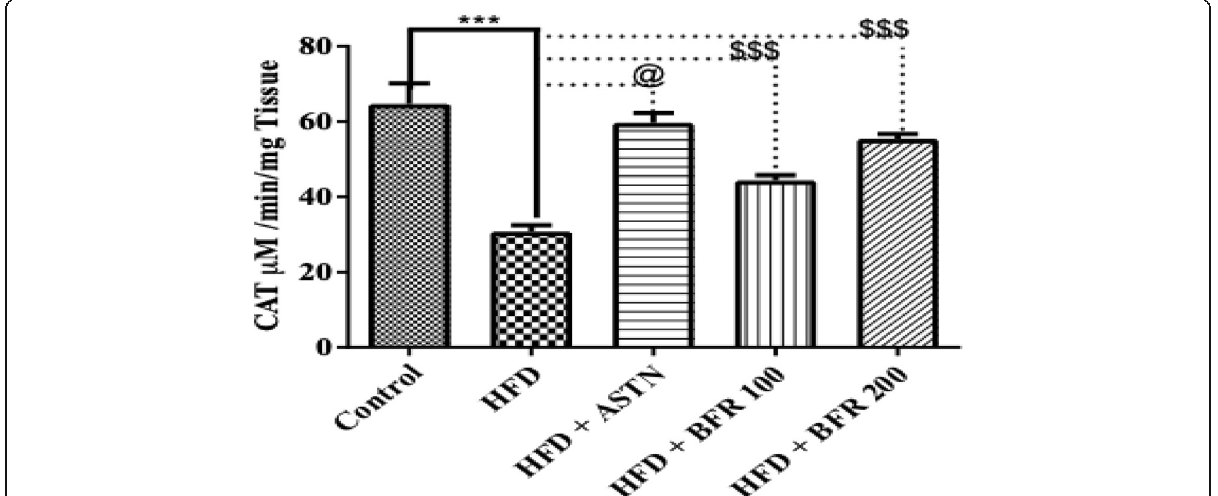
Fig. 6 Effect of BFR and ATSN in heart catalase level of high-fat diet-fed rat. Data were expressed as mean ± SD. Comparison made between HFD